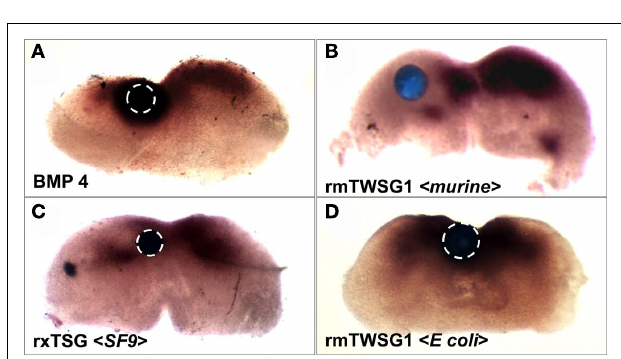
FIGURE 5 | SPR interaction analysis of BMP2 binding to recombinantTsg proteins derived from different sources. Binding of recombinantTsg proteins to a BMP2 biosensor was analyzed using SPR. BMP2 was immobilized on a GLC-chip via amino coupling. Indicated concentrations ofTsg proteins were perfused over the biosensor surface, injection started at time point 0 with a duration of 240s (association phase) after which only buffer was again perfused for 660s to record the dissociation ofTsg from BMP2. (A,B) . The BMP2 biosensor was perfused with varying concentrations of (A) xTsg